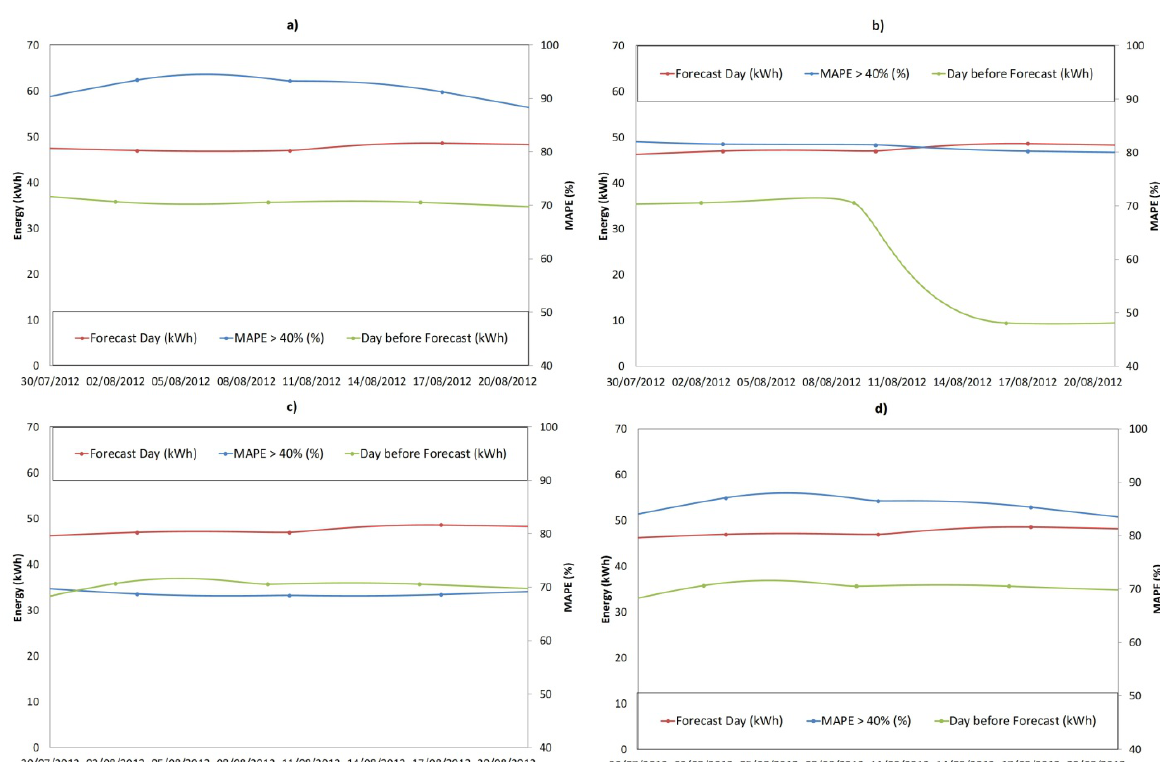
Figure 10. MAPE (%) (1) over 40%, 3–20 August 2012 . Fridays: ( a ) F_L ; ( b ) F_L_W